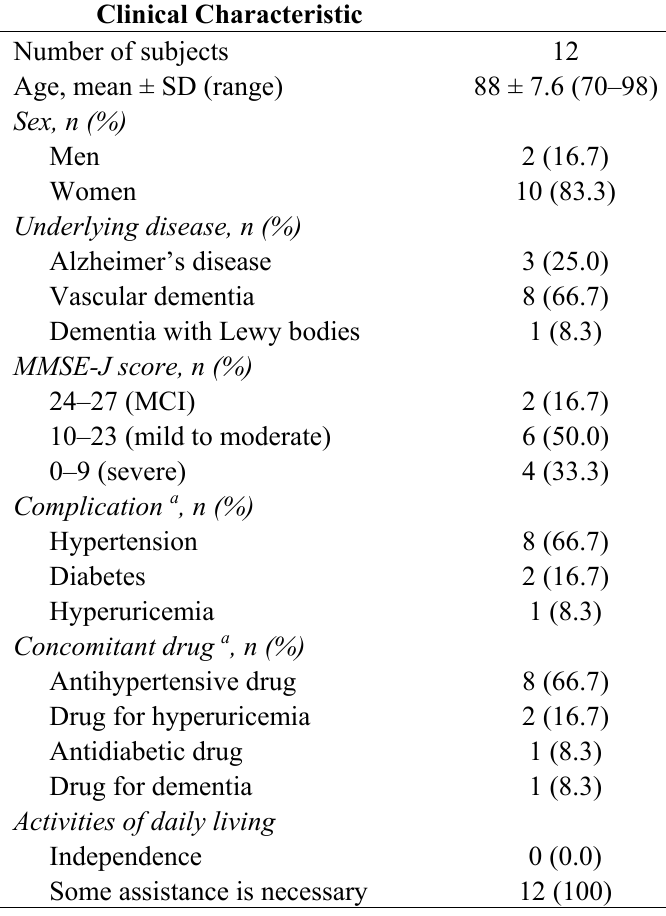
Table 1. Clinical characteristics of study